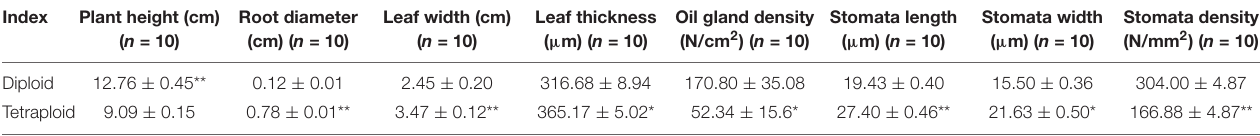
TABLE 1 | Morphology and stomatal indices of tetraploid and diploid seedlings of Citrus wilsonii .